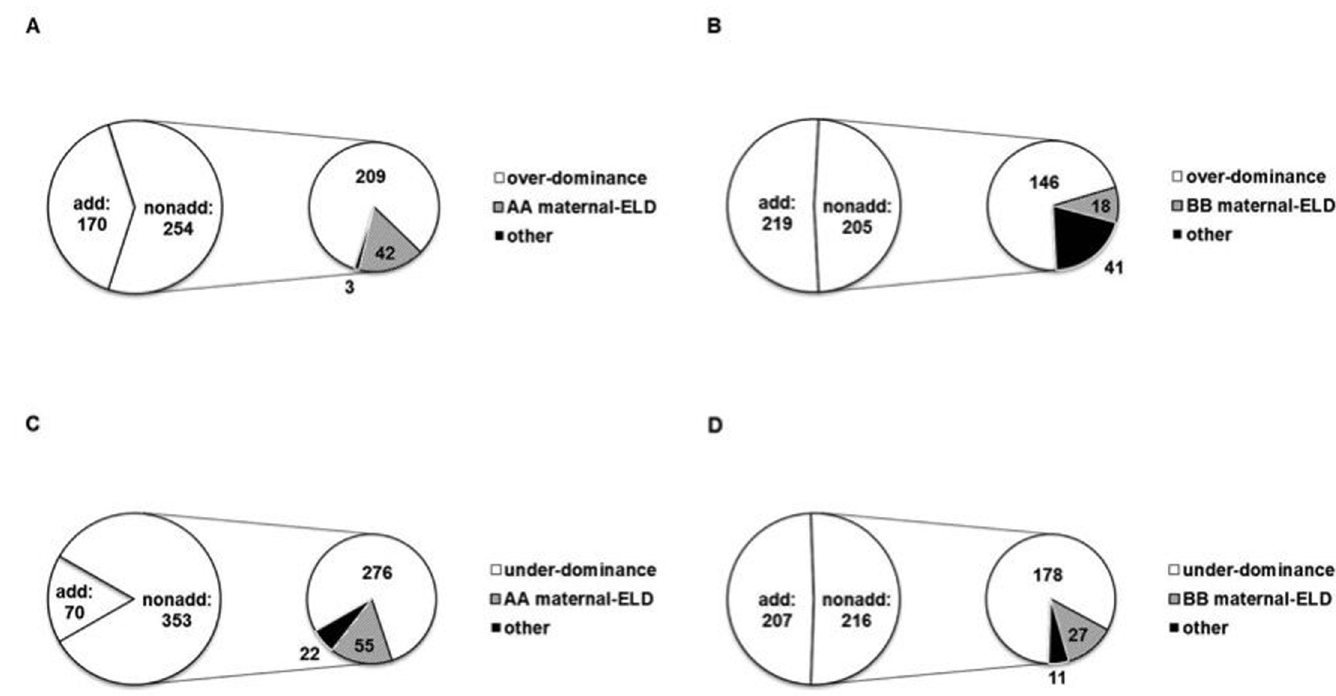
Fig 1. Pie chart of differentially expressed genes (DEGs) in up-regulated (A, B) and down-regulated (C, D) transcripts in Zhengdan958 (A, C) and Anyu5 (B, D). add and nonadd represent additive and non-additive genes. maternal-ELD: maternal expression-level dominance. AA and BB represent Zheng58 and Ye478,